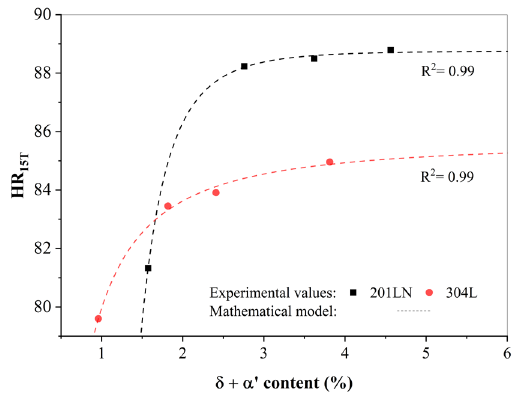
Figure 6. Residual stresses in 201LN and 304L steels with different shot peening times.